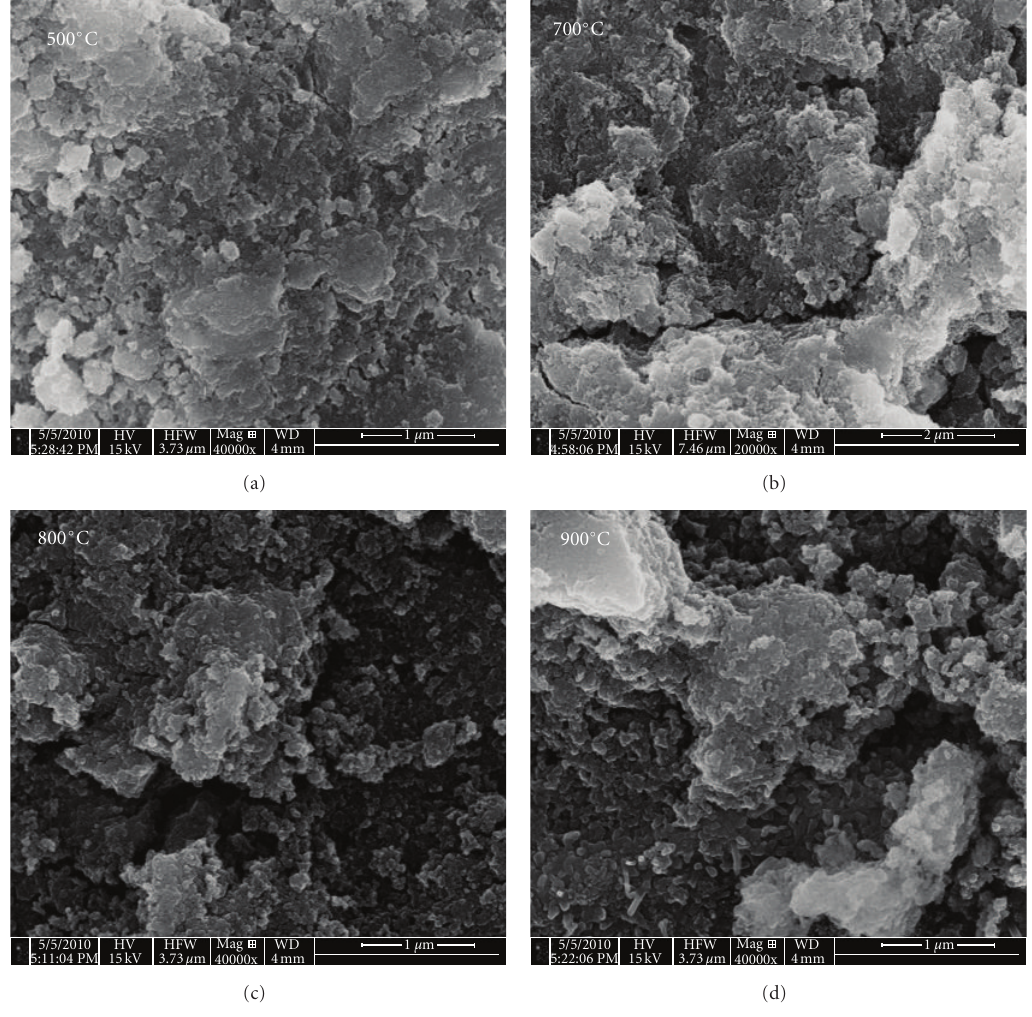
Figure 10: SEM of heat-treated hydroxyapatite coatings.